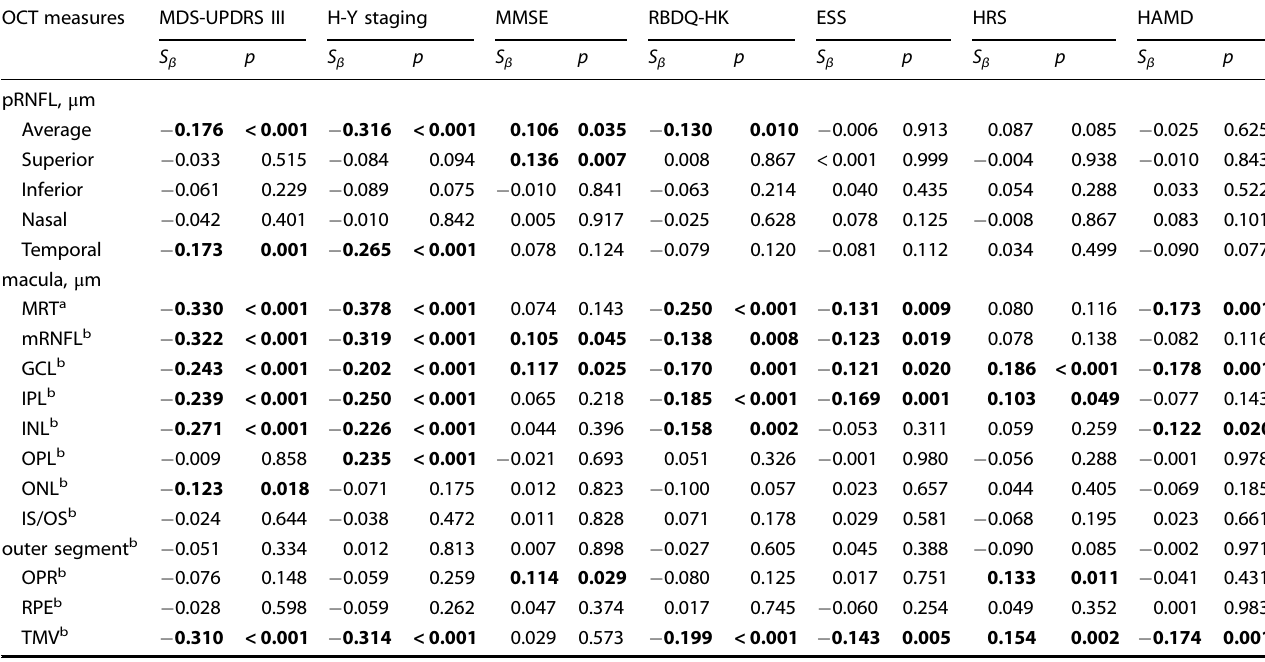
Table 2. Relationships between retinal measures and MDS-UPDRS III, H-Y staging, non-motor symptoms in the PD patients. OCT